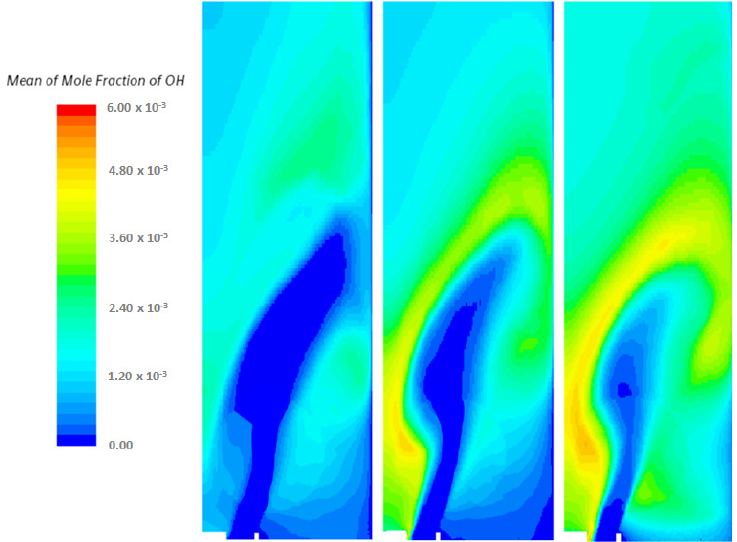
Figure 9. Mean mole fraction of OH. ( Left ) 20/80; ( Centre ) 40/60; ( Right ) 60/40 (vol%) methane/ammonia blends under stoichiometric conditions.